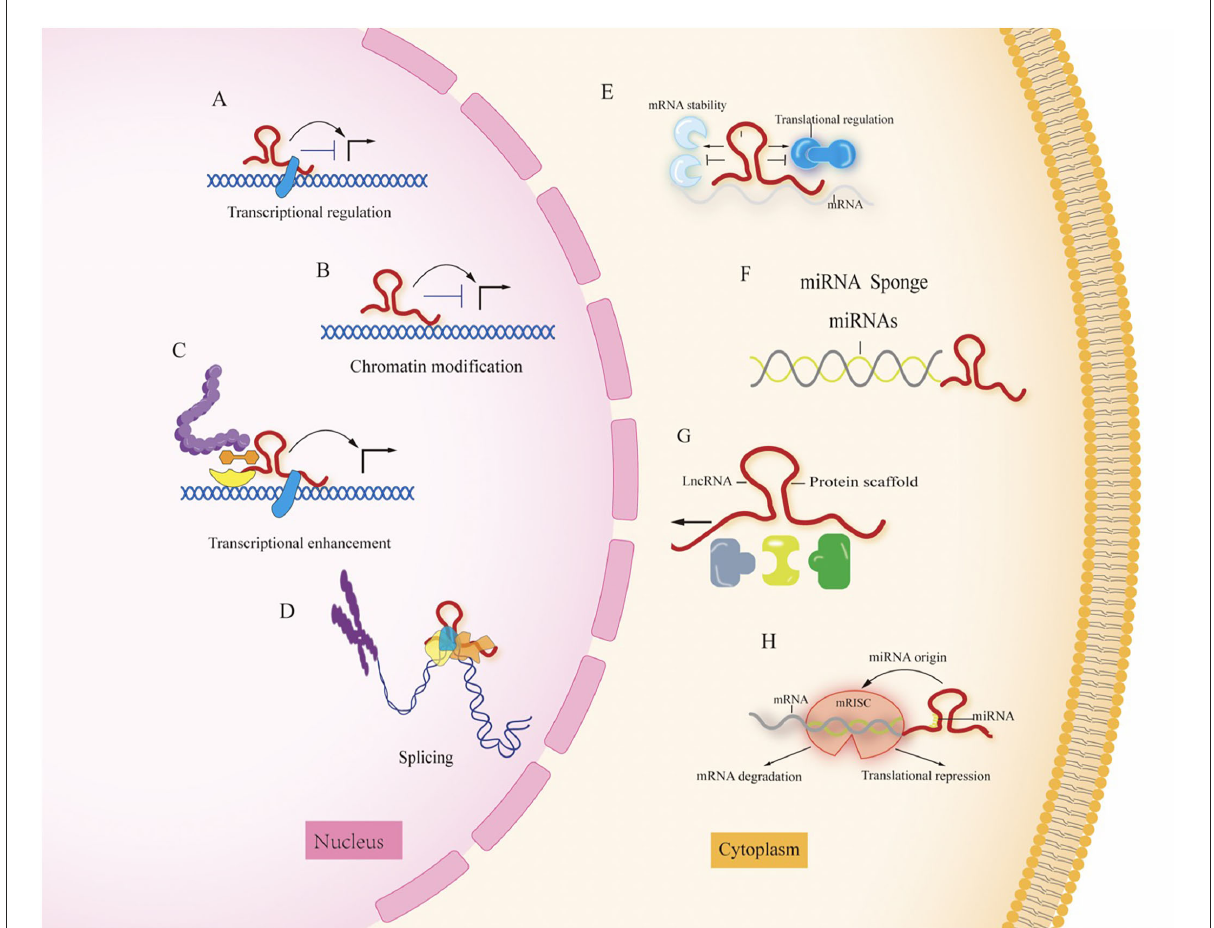
FIGURE2 The different roles of LncRNA in the nucleus and cytoplasm. (A) Transcriptional regulation; (B) chromation modification; (C) transcriptional enhancement; (D) splicing; (E) regulation of mRNA stability; (F) miRNA sponge; (G) protein scaffold; (H) LncRNAs can function as miRNA host transcripts (miRNA origin). Mature single-stranded miRNA is derived from lncRNA transcripts and loaded into RNA induced silencing complex (RISC) by repressing translation or inducing mRNA degradation.